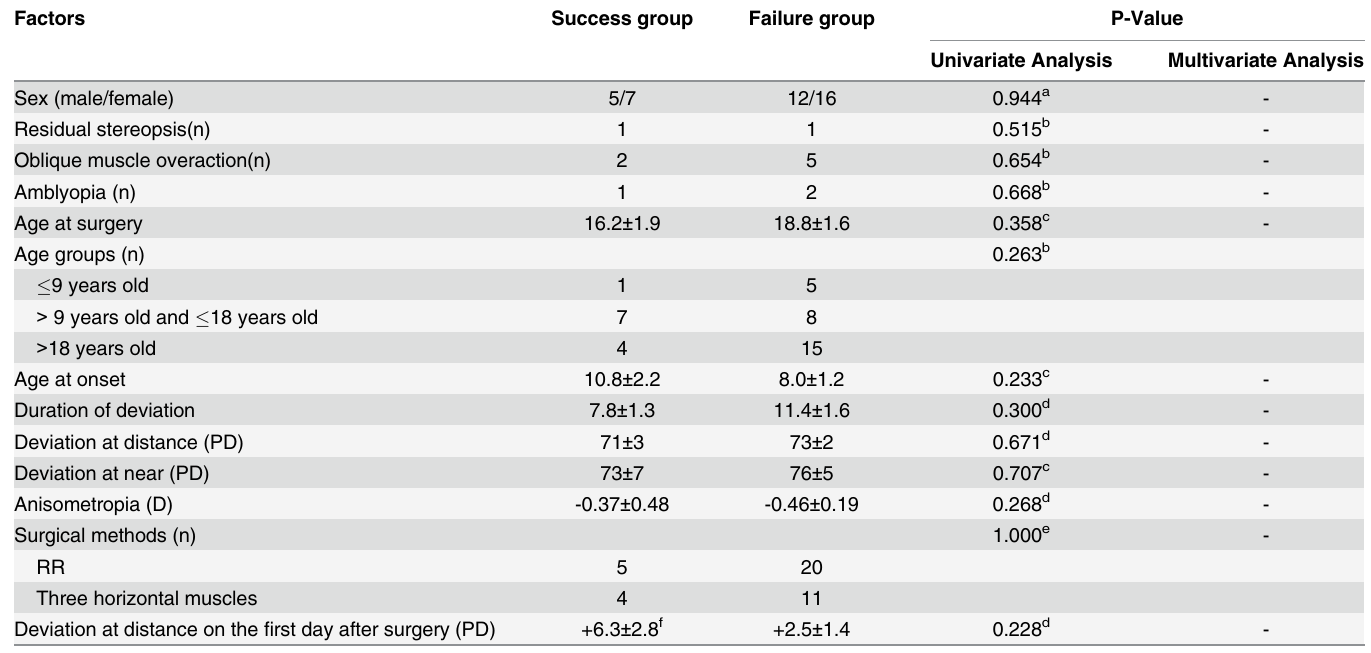
Table 2. Preoperative risk factors for poor